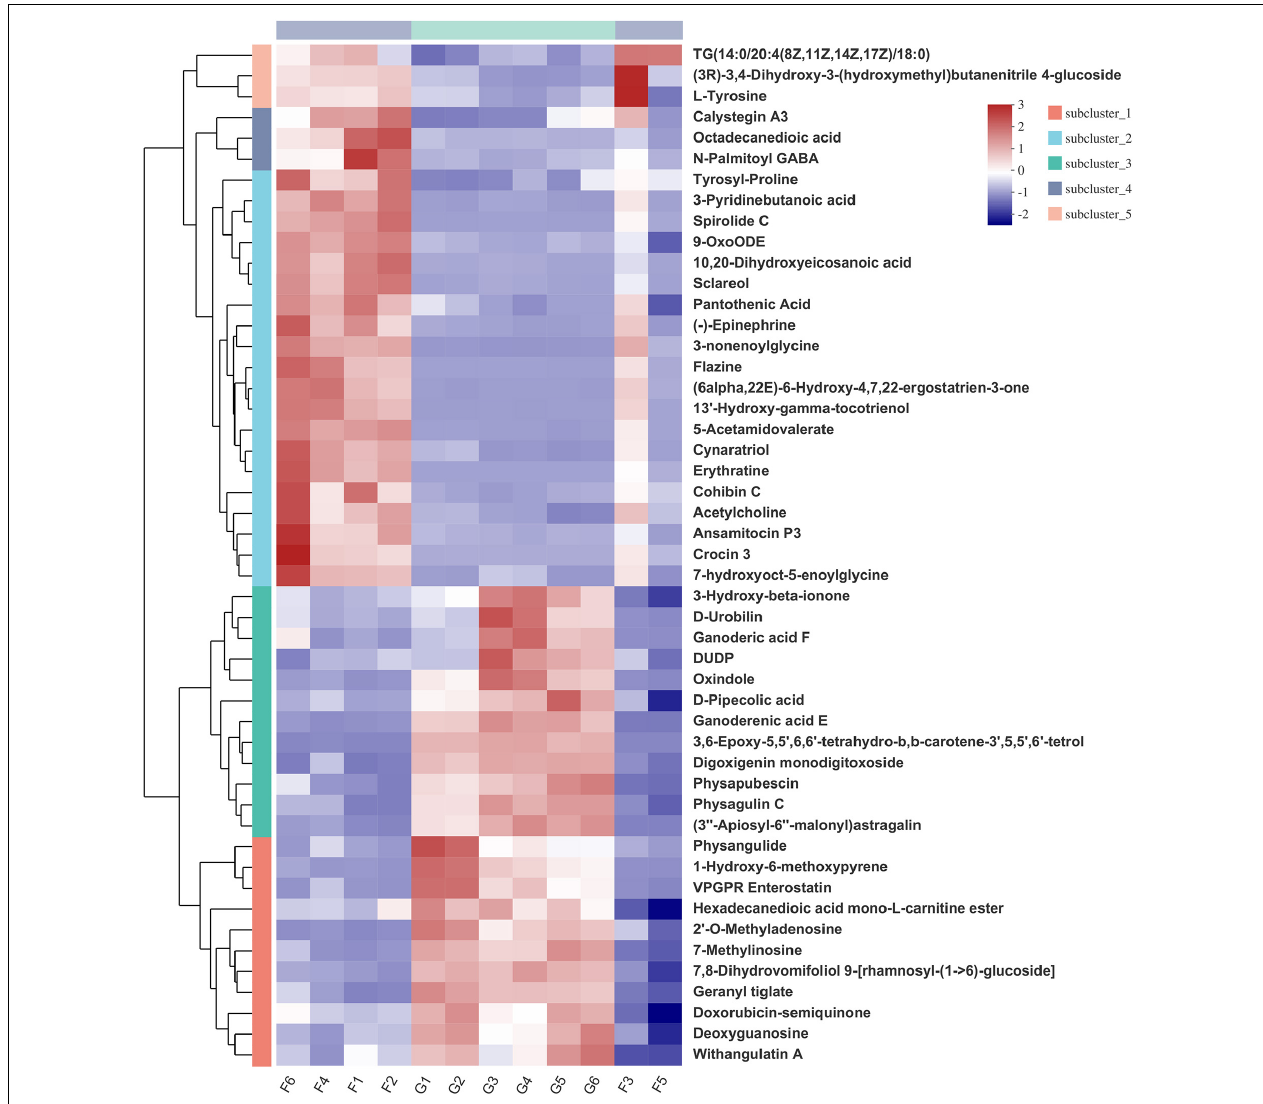
FIGURE 6 | Hierarchical clustering analysis (HCA) with a heat map for the expression of different metabolites in yak rumen between grazing group and house fattening group following positive mode